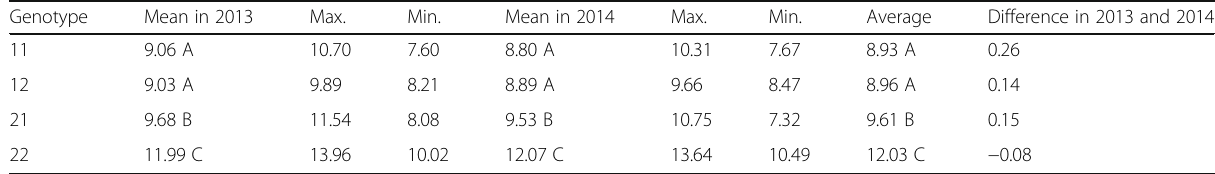
Table 5 Difference of AC for different genotypes in SSIIa and SSIIIa locus of 64 semi waxy lines in 2013 and 2014